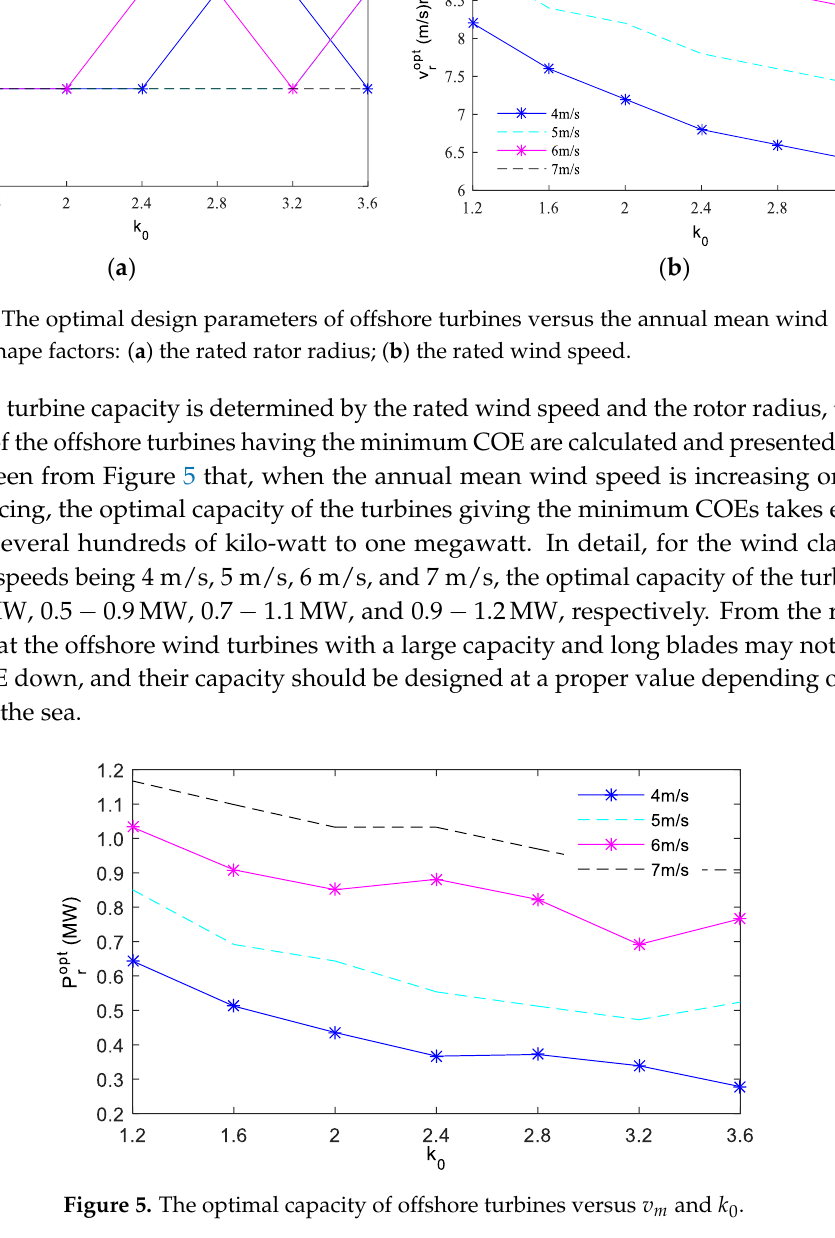
Figure 5. The optimal capacity of offshore turbines versus